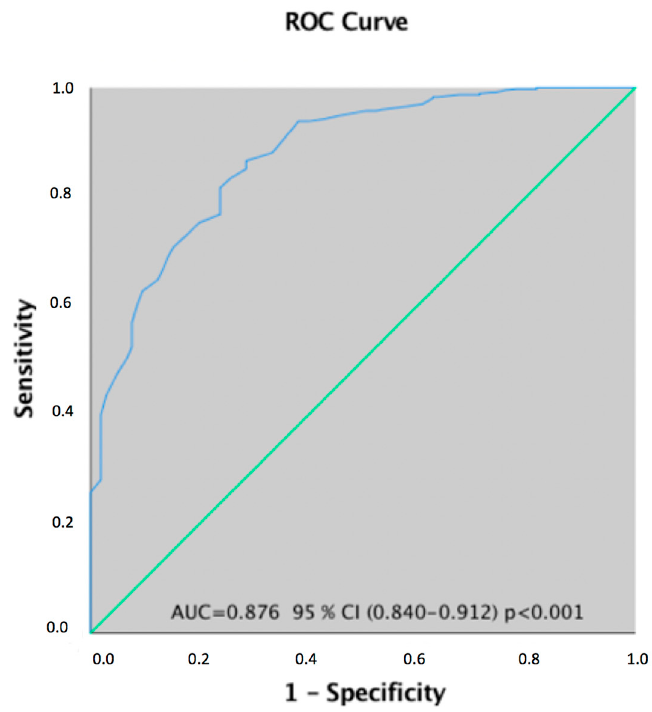
Figure 2. Relative operating characteristic (ROC) curve used to determine the predictive value of MCP in the diagnosis of children with neurodevelopmental disorder.